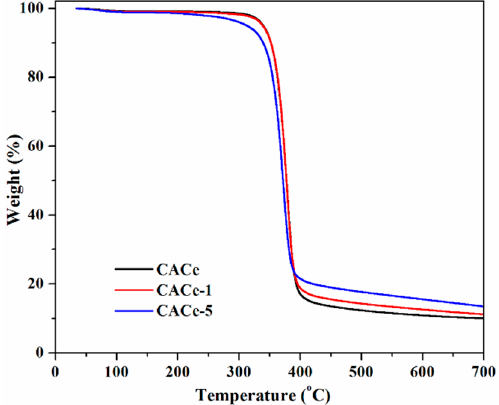
Figure 8. Thermogravimetric analysis (TGA) thermograms for CACe, CACe-1 and CACe-5